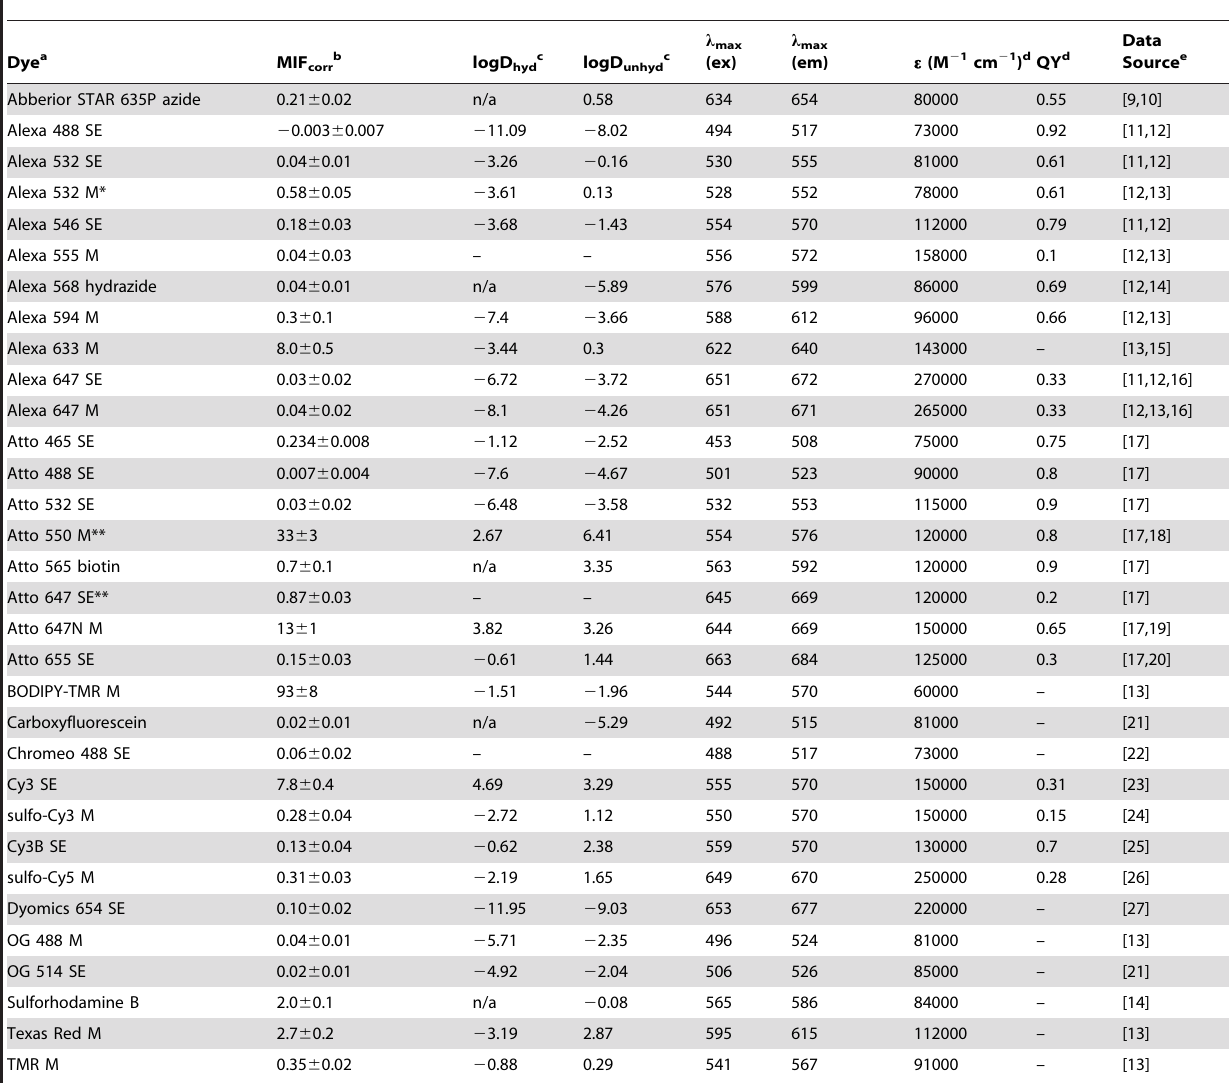
Table 1. MIF Values, Calculated Log D Values, and Photophysical Characteristics of Common Water-Soluble Dyes.